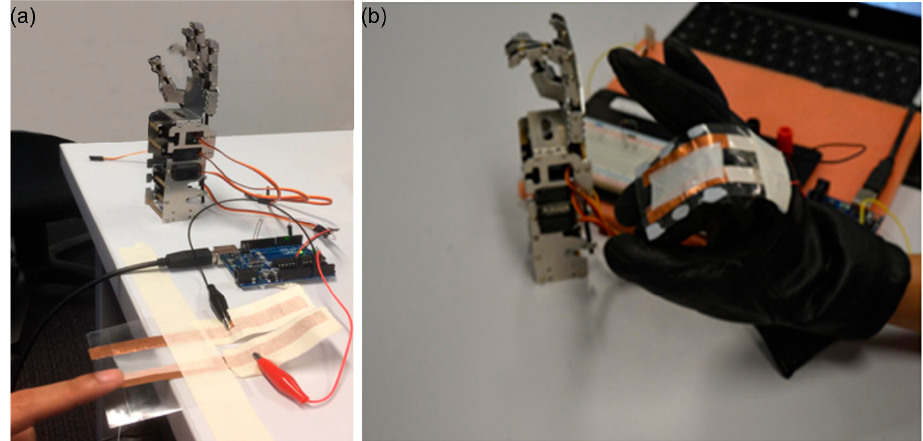
Figure 8. ( a ) experimental setup of using one PVDF electrospun strain sensor connected to a robotic finger; ( b ) experimental setup of mounting five sensors on a glove to detect finger motion and transfer it to the robotic arm (video of experiment is available in the Supplementary Materials).